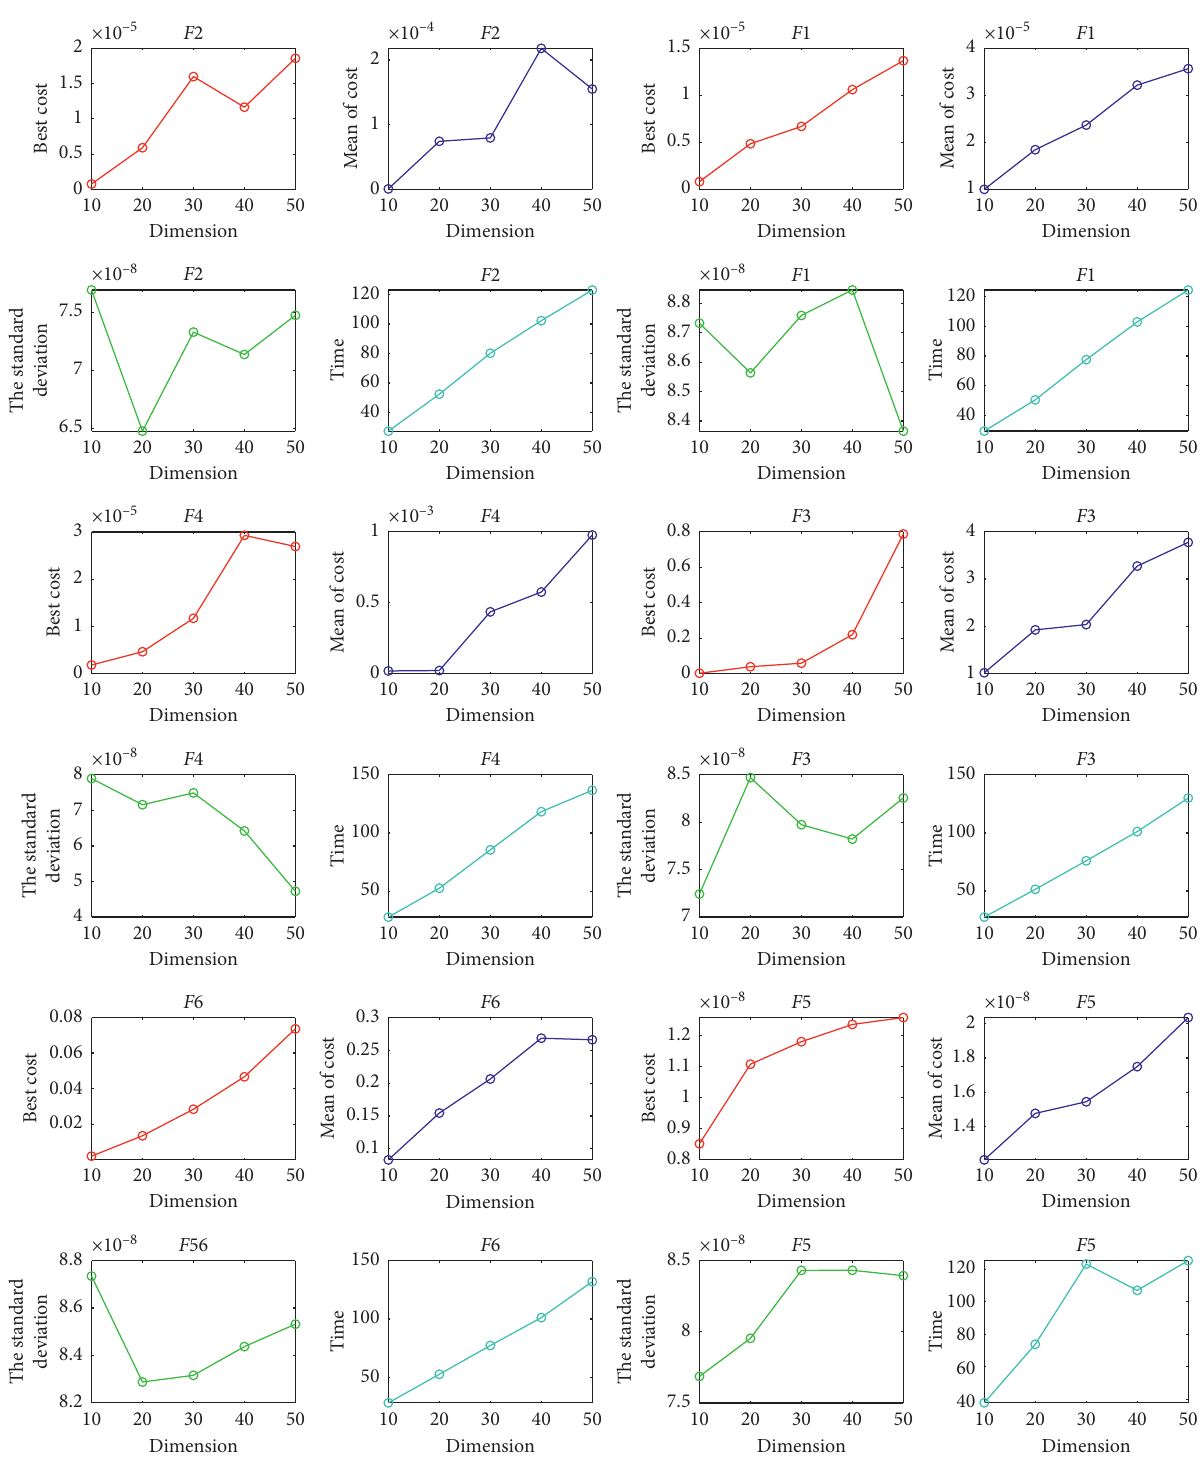
Figure 2: The best costs of population individuals and their mean and standard deviation and the proposed method execution time on F 1– F 6 functions of the test benchmark versus different dimension